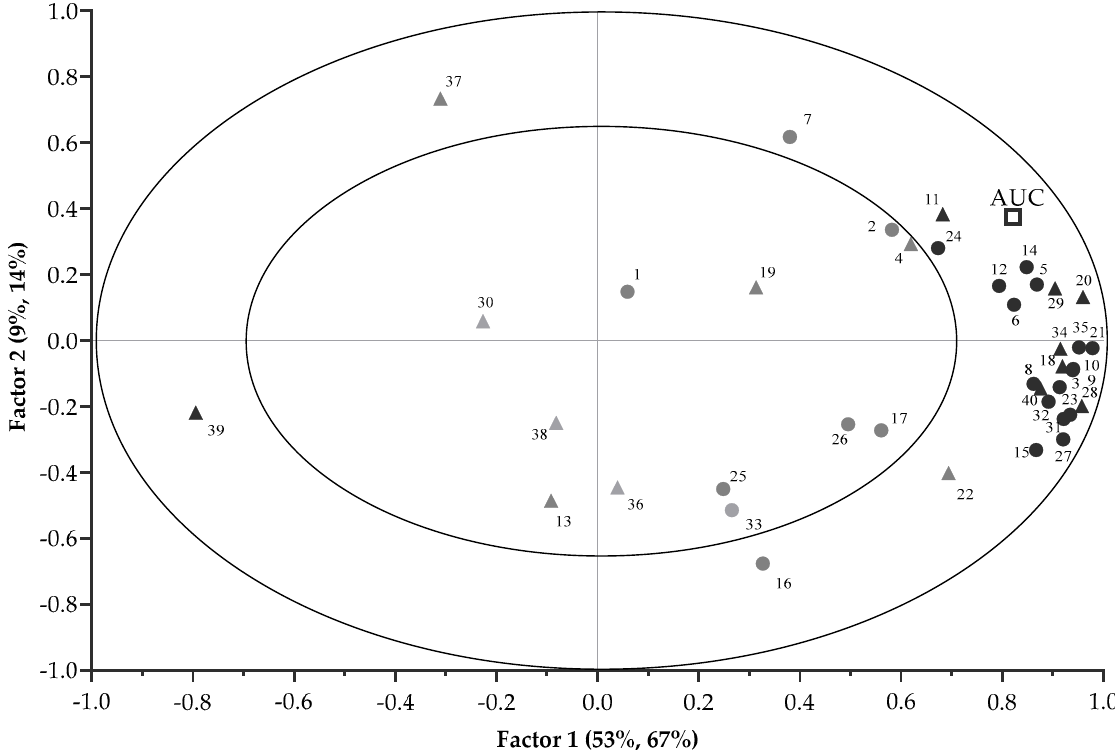
Figure 3. Correlation loading plot of the PLSR analysis with the 16 important mVOCs and 8 non-mVOCs (in bold) contributing to variance of preference-AUC ( • mVOCs; ▲ non-mVOCs). The numbers correspond to compound names as in Table 3. The outer ellipse indicates 100% explained variance. The inner ellipse indicates 50% of explained variance.